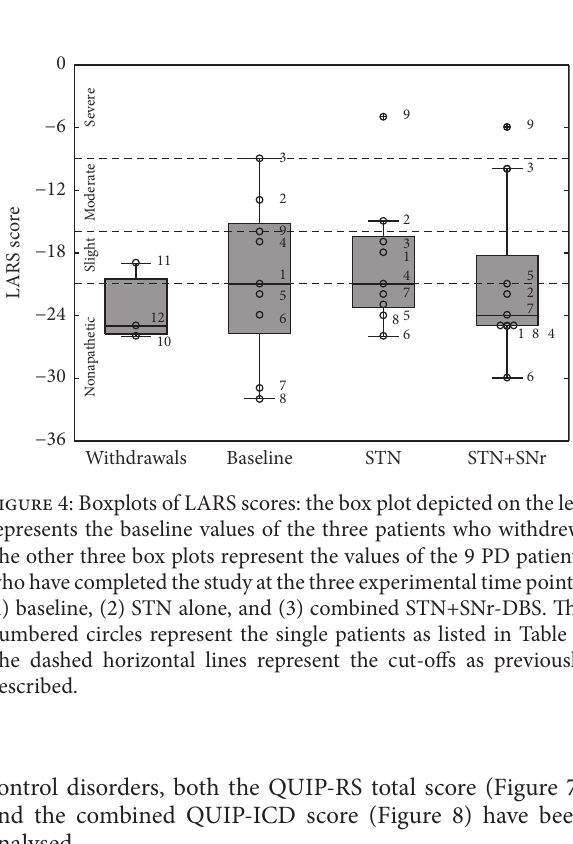
Figure 3: Stereotactic reconstruction: squares indicate the localization of the most ventral DBS electrode contacts, superimposed on frontal sections of the stereotactic atlas of Morel, at a level 5mm behind midcommissural point [50]. Circles indicate the ventral STN border as defined by standard electrophysiological criteria. Diamonds indicate the presence of unambiguous SNr cell activity on MER tracks. Colors represent individual patients. The dashed red lines denote midline and AC-PC level, respectively. STN: subthalamic nucleus; SNr: substantia nigra pars reticulata; SNc: substantia nigra pars compacta; CP: cerebral peduncle; RN, red nucleus.